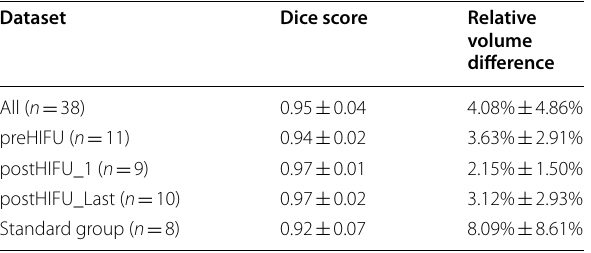
Table 3 Mean Dice scores and mean relative volume difference reported for the entire hold-out test data and separately for the preHIFU dataset, the early (postHIFU_1) and last follow-up (postHIFU_Last) after HIFU treatment, as well as for the non- fibroid standard group Dataset Dice score Relative